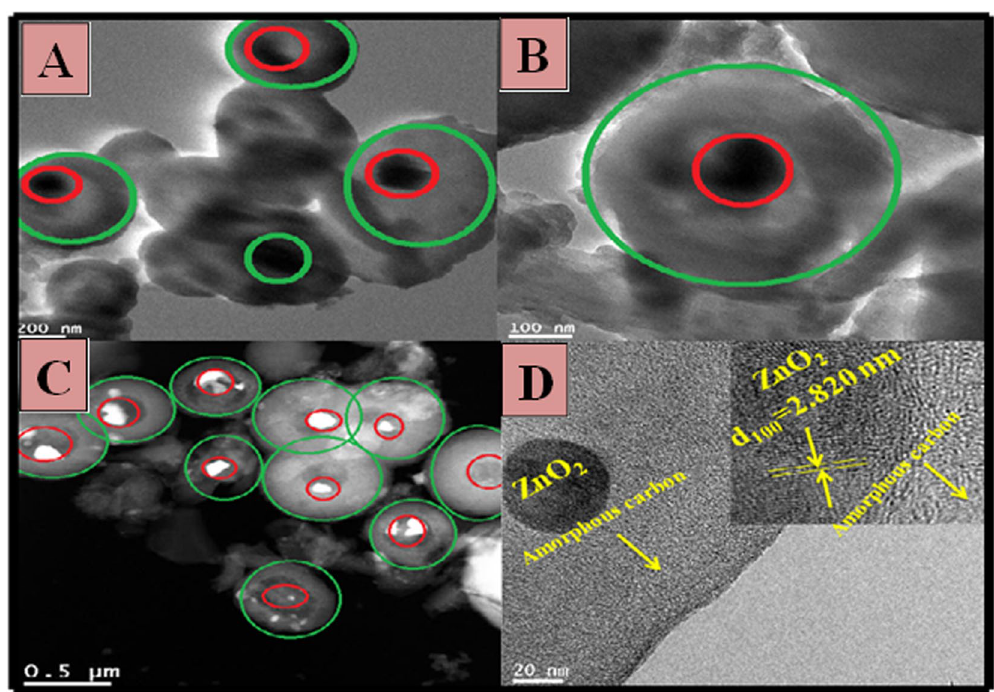
Figure 3. ( A–C ) TEM images, ( D ) High resolution TEM image for the obtained core@shell (ZnO@C) microspheres after carbonized at 700 °C for 2 h in nitrogen